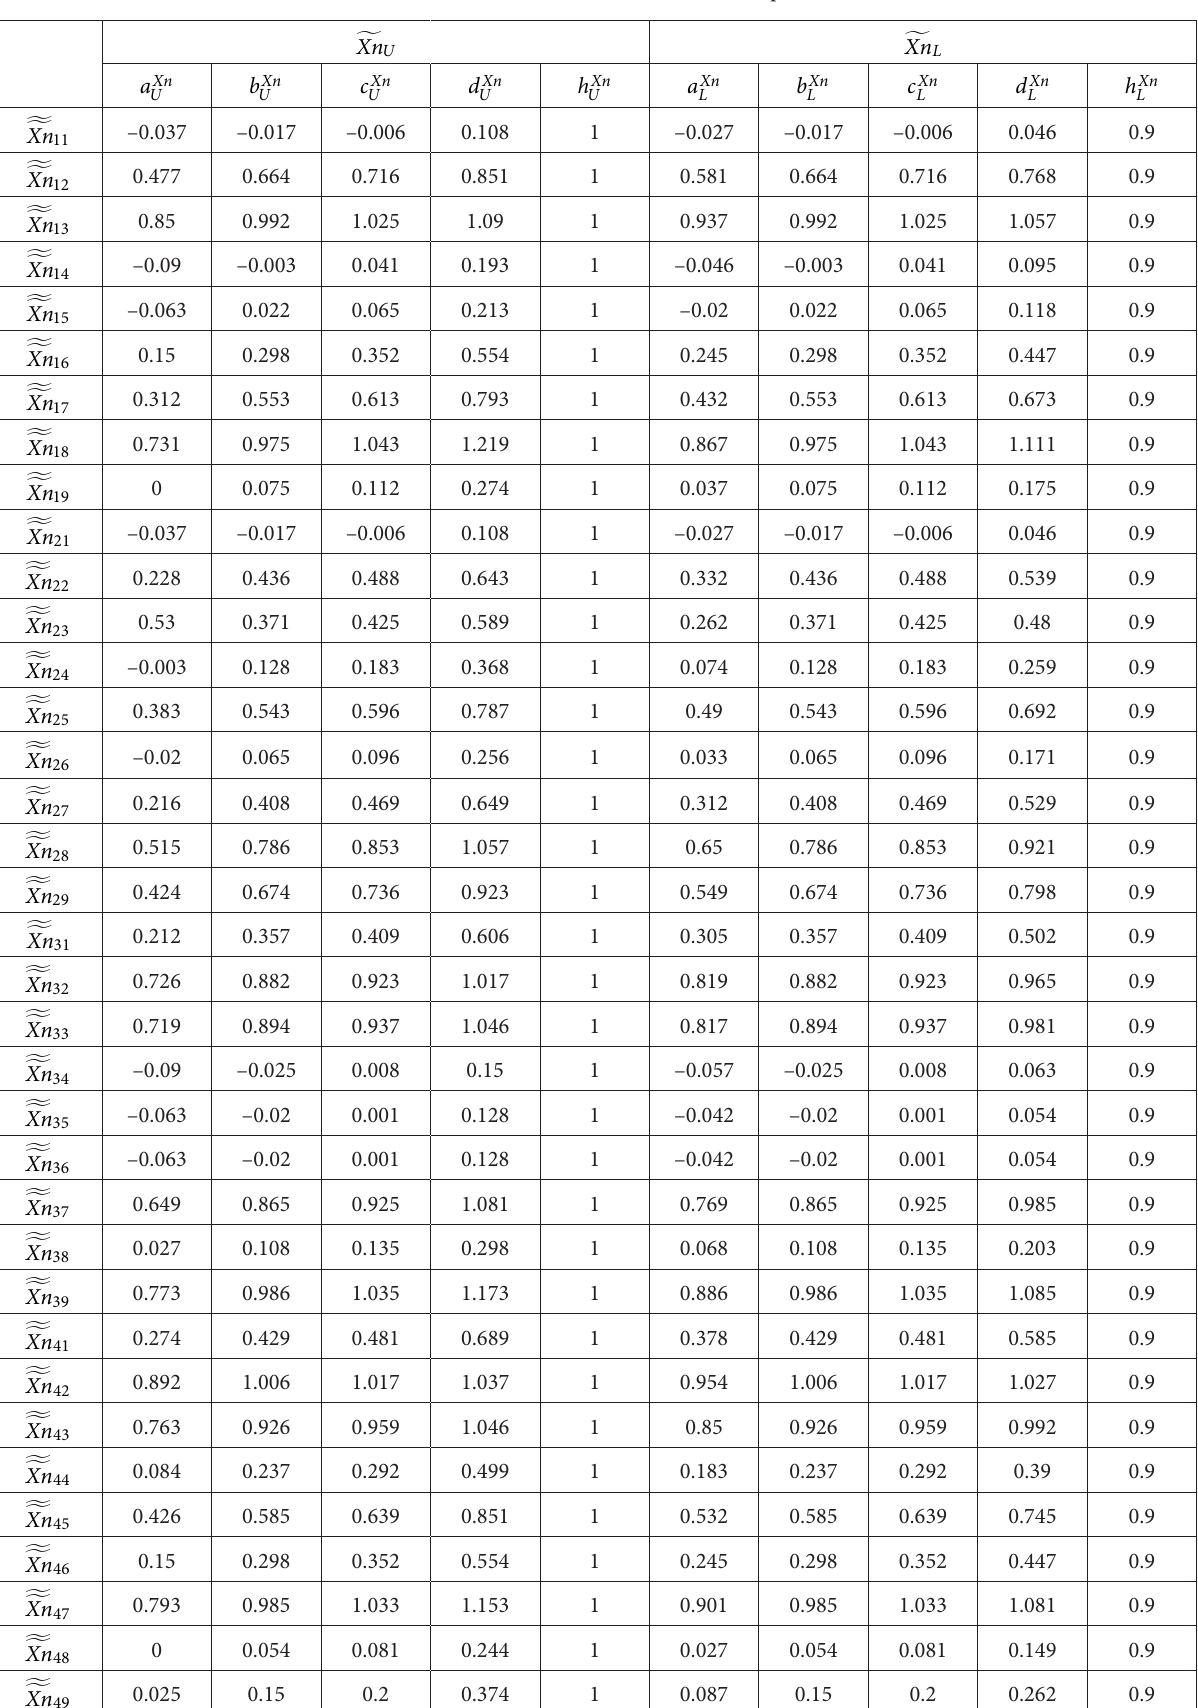
Table 7. The normalized decision-matrix of the